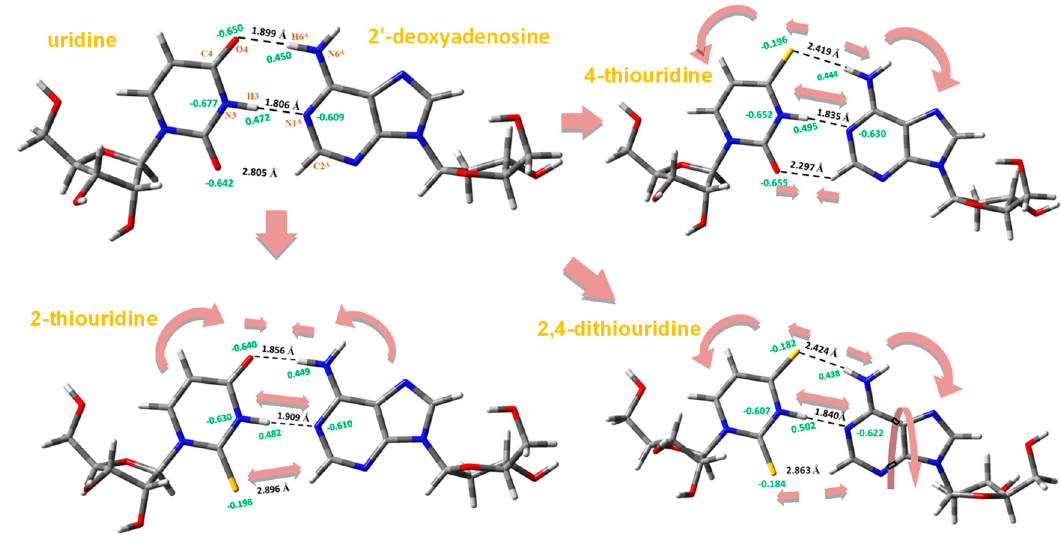
Figure 7. Comparison of the effects on the intermolecular H-bonds of the pair with the substitution of the oxygen atom by a sulphur atom in the natural WC pair uridine···2 ′ -deoxyadenosine at the M062X/6-31G(d,p) level. The NBO atomic charges are plotted in green color.